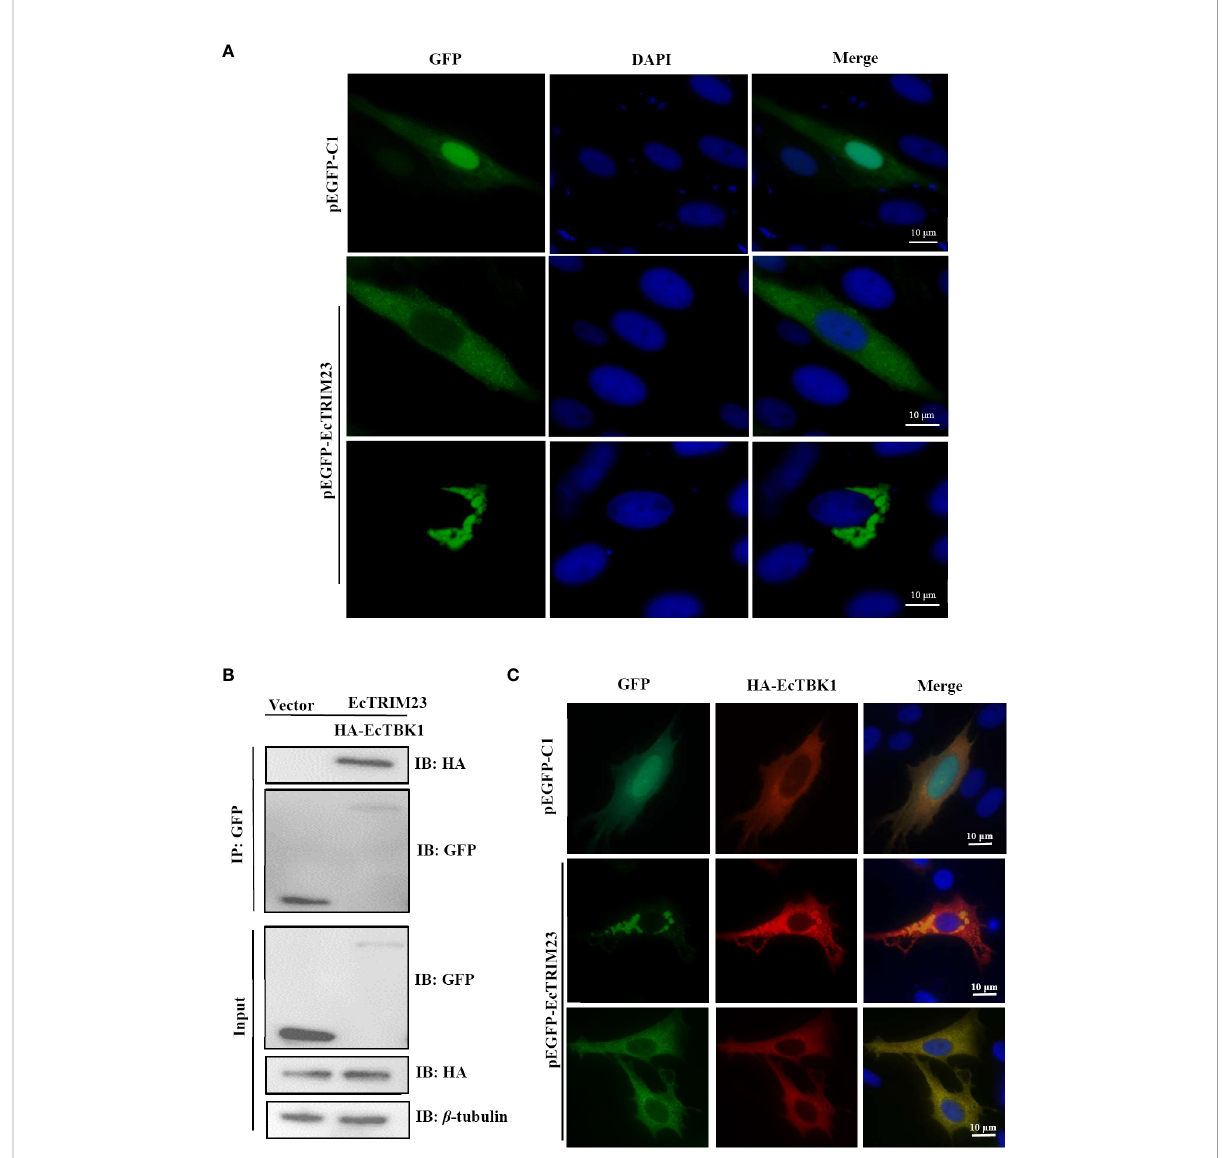
FIGURE 5 EcTRIM23 recruited and interacted with EcTBK1. (A) Subcellular localization of EcTRIM23 in grouper cells. GS cells were transfected with pEGFP-C1 or pEGFP-EcTRIM23 for 48 h After fi xation, the cells were stained with DAPI. The fl uorescence was observed under fl uorescence microscopy. (B) EcTRIM23 interacted with EcTBK1. GS cells were co-transfected with pEGFP-EcTRIM23 or pEGFP-C1 and HA-EcTBK1 for 48 h The cells were lysed and immunoprecipitation using the Dynabeads ™ Protein G incubation with anti-GFP. Then the Dynabeads-Ab-Ag